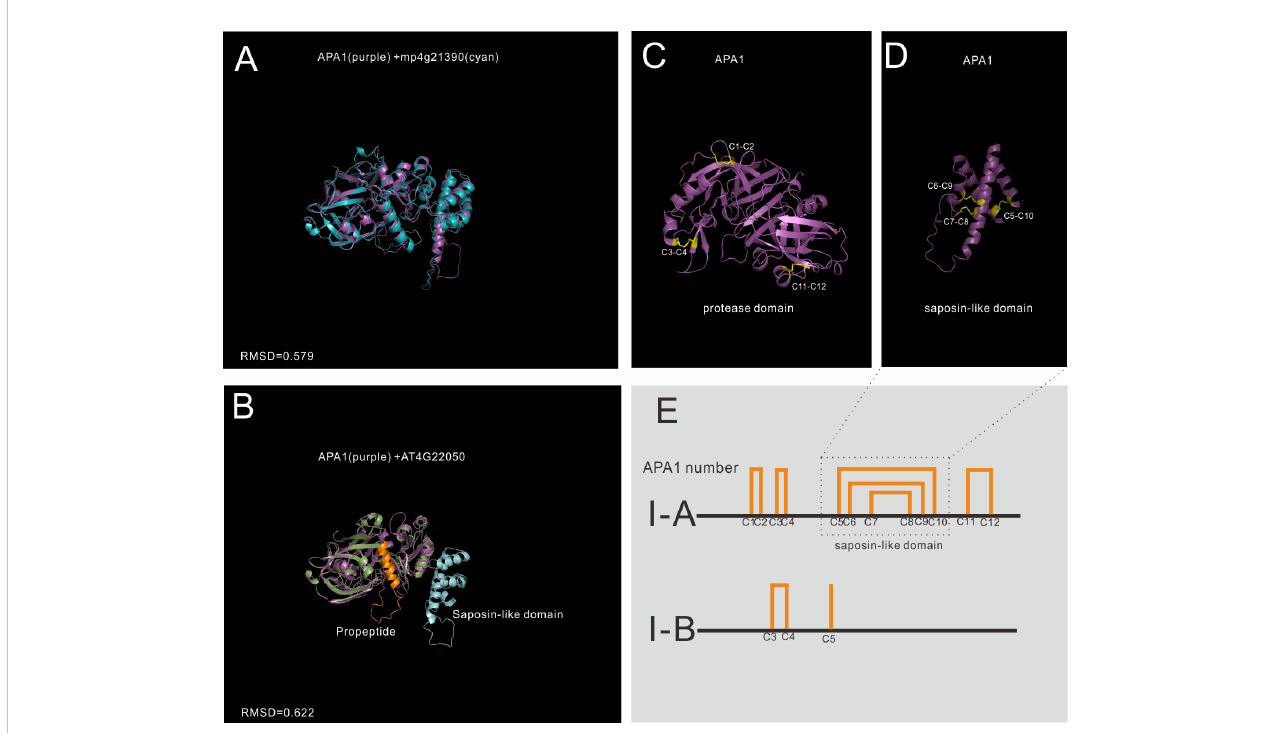
FIGURE 3 AlphaFold predicted structure models of group I (subgroup I-A and subgroup II-B) (A) Structure alignment of APA1 and its Marchantia polymorpha mp4g21390; (B) Structure alignment of subgroup I-A (APA1) and subgroup I-B (AT4G22050); (C) The disul fi de bonds of mature APA1 protease domain; (D) The disul fi de bonds of saposin-like domain; (E) Disul fi de bond topology of subgroup I-A and